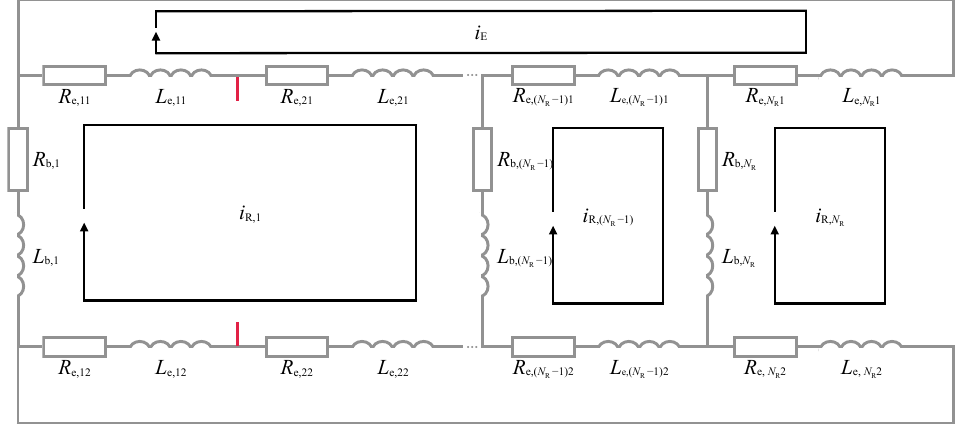
Figure 3. Electrical network of a rotor of a squirrel cage induction motor with the individual loop currents i R in case of one broken cage